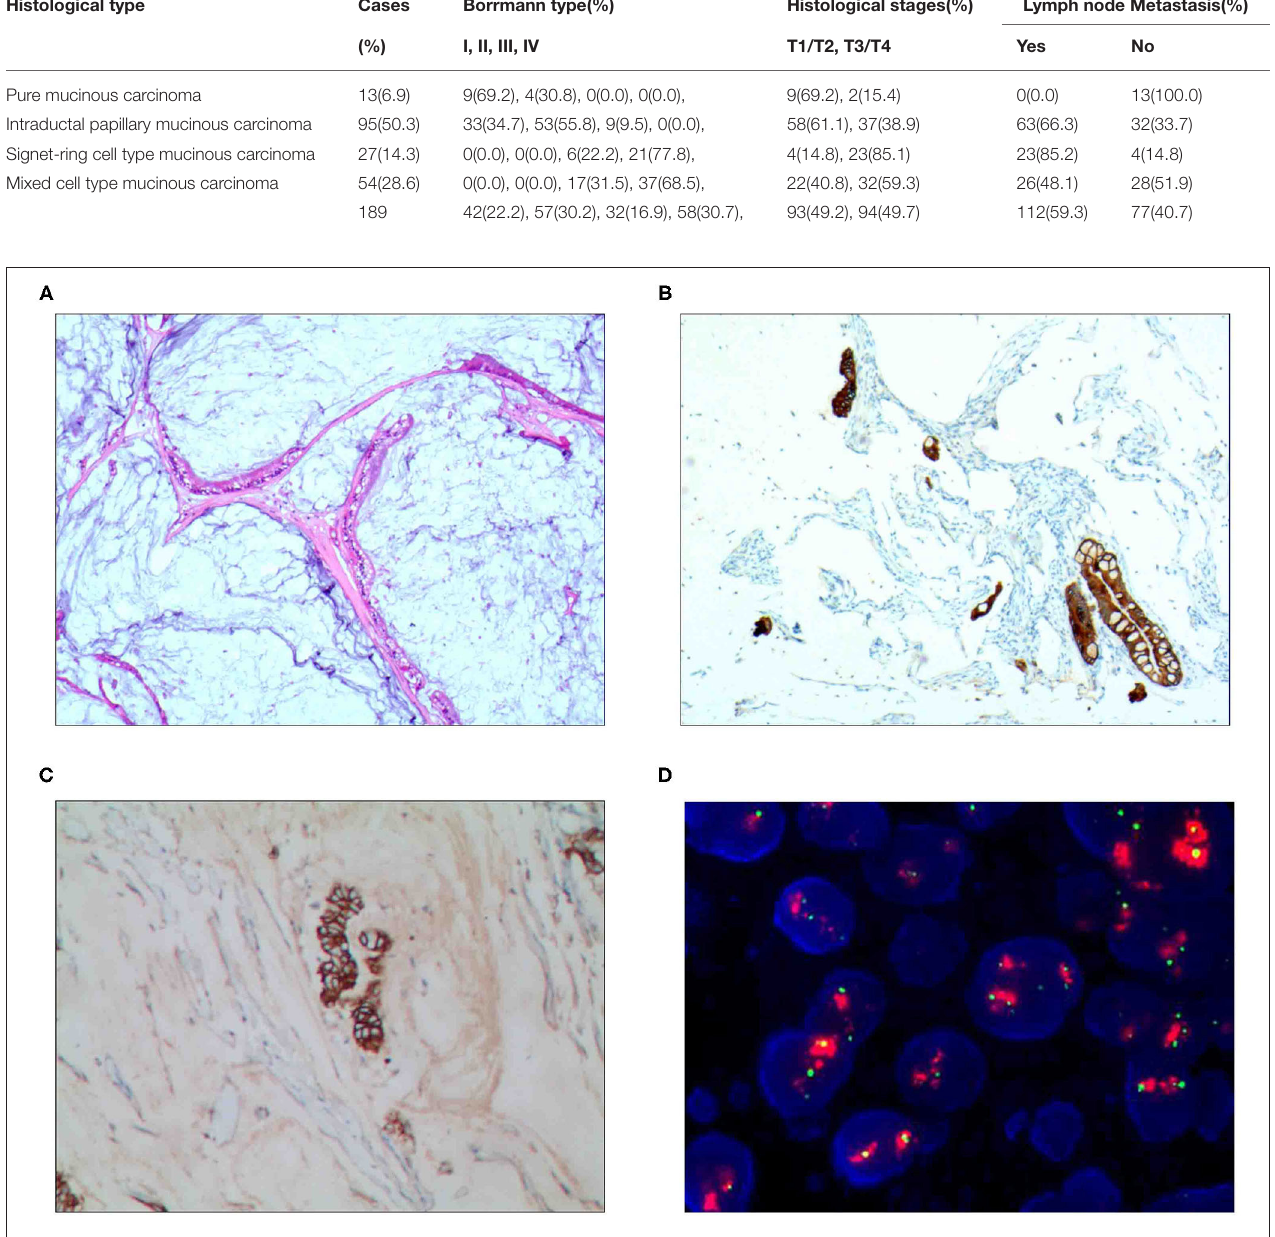
FIGURE 1 | Pure mucinous carcinoma. (A) It was composed of differentiated adenocarcinoma cells and mucinous tissues, wherein mucus was the main tissue, accounting for more than 90%; H&E staining, × 100. (B) CKpan was positively expressed in the differentiated adenocarcinoma cells; EnVision TM method, × 100. (C) The HER2 protein was positively expressed in the differentiated adenocarcinoma cells; EnVision method TM , × 100. (D) The HER2 gene was amplified in a cluster shape; red stands for the probe signal, and green stands for chromosome 17. The FISH method was used